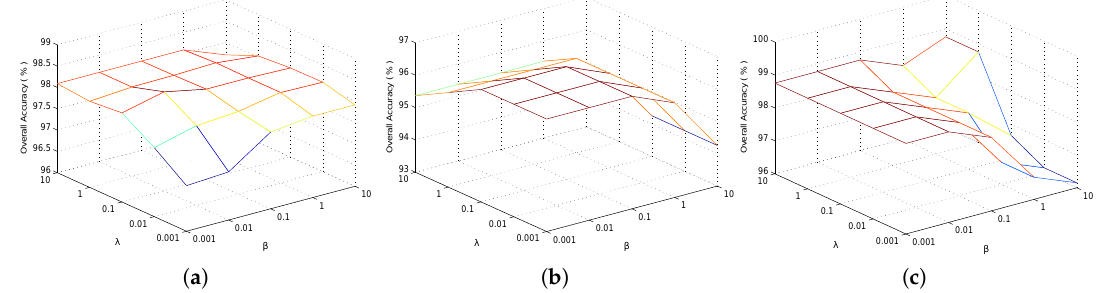
Figure 2. Parameter tuning of β and λ for the proposed TSLGDA algorithm using three datasets: ( a ) Indian Pines; ( b ) University of Pavia; ( c )